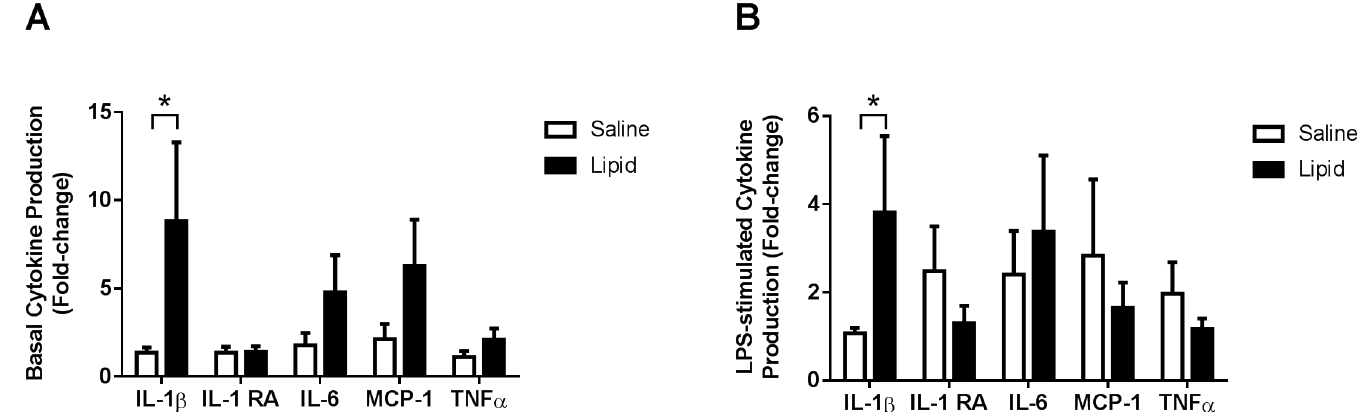
Fig 3. Effects of lipid infusion on cytokine production in cultured monocytes. Monocytes were isolated using a Dynabeads 1 Untouched™ Human Monocytes Kit. Two hundred thousand cells were either left untreated or treated with 1 μg/ml LPS for 18 h. Basal (A) and LPS-stimulated (B) cytokine production was determined by multiplex assay as described under ‘Materials and methods’. All values are mean ± SEM of data obtained from 12 subjects. (cid:3) P < 0.05.